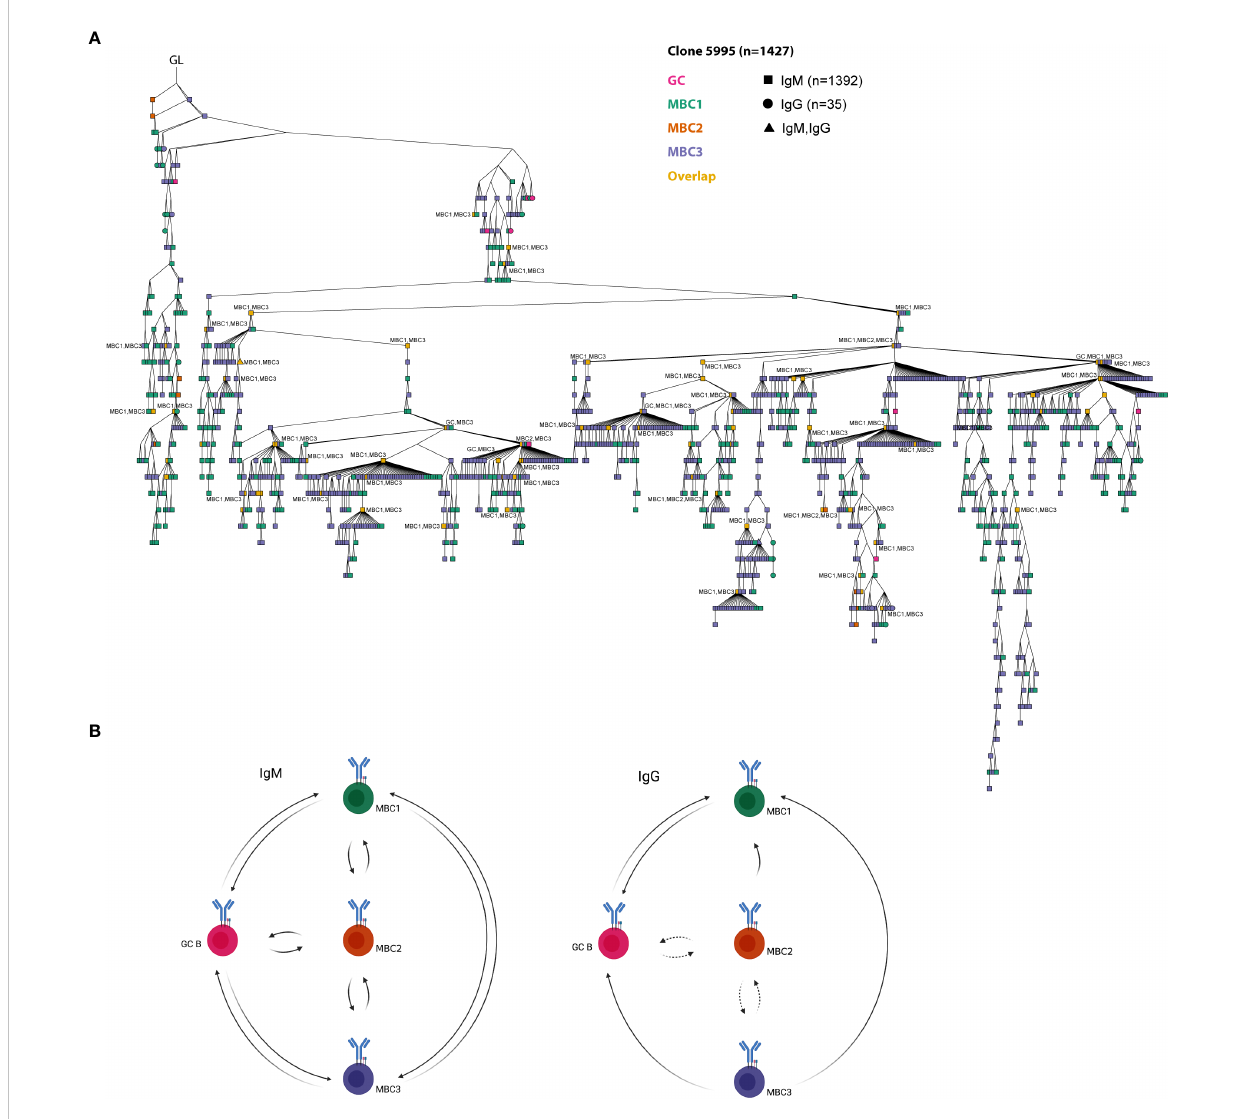
FIGURE 7 A model on clonal relationships between MBC subsets and GC B cells. (A) The largest clone from the lineage tree analysis. GL is indicated in the fi gure. The different MBC subsets and GC B cells are indicated in the fi gure. At certain nodes overlap between different MBC subsets and with GC B cells can be observed (in orange). Overlapping sequences for IgM and IgG are also indicated (triangle shape). Overlapping nodes without text are identical to those of their ancestor. Results from a pool of 6 mice. (B) A model on the clonal relationships between MBC1-3 and GC B cells shown for IgM and IgG separately based on our lineage tree analyses. Created with